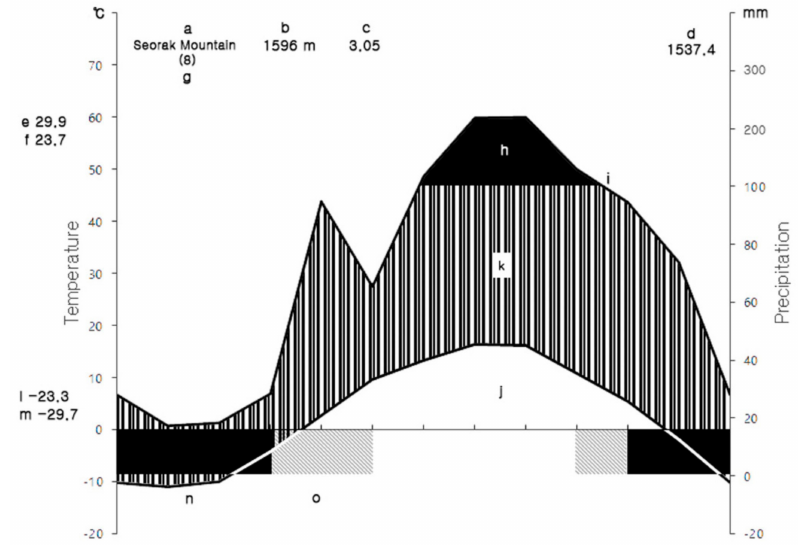
Figure 1. Climate diagram in Seorak Mountain for the recent eight years. Note: ( a ) Station name; ( b ) height above sea level (m); ( c ) mean annual temperature ( ◦ C); ( d ) mean annual amount of precipitation (mm); ( e ) absolute maximum temperature ( ◦ C); ( f ) mean daily maximum of the hottest month ( ◦ C); ( g ) number of years of observation; ( h ) average monthly precipitation exceeding 100 mm (black area); ( i ) monthly means of precipitation (mm); ( j ) monthly means of temperature ( ◦ C); ( k ) humid period (lined); ( l ) mean daily minimum temperature of the coldest month ( ◦ C); ( m ) absolute minimum temperature ( ◦ C); ( n ) months with a mean daily minimum temperature below 0 ◦ C; and ( o ) months with an absolute minimum temperature below 0 ◦